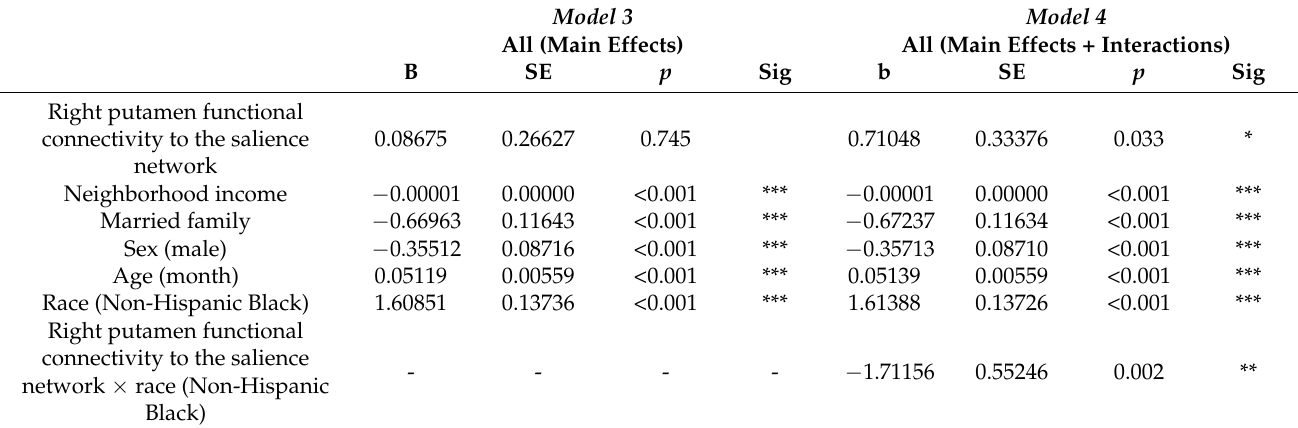
Table 4. Parameter estimates for the effects of right putamen functional connectivity to the salience network on children’s